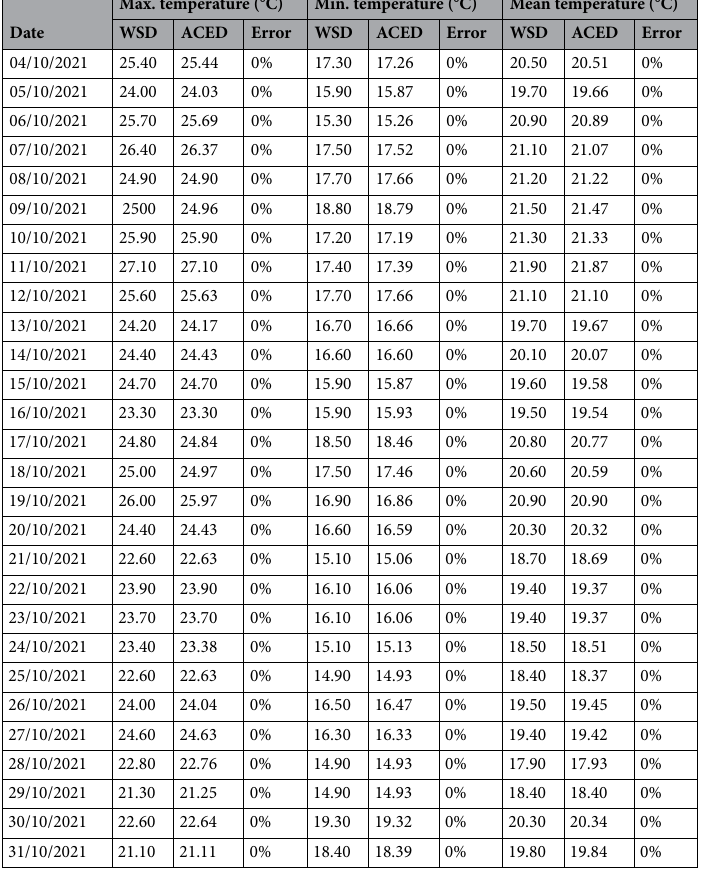
Table 3. Comparison of temperature data obtained by the AgroClimatic web application and by the Meteorological Data Service. WSD: Weather Service Data. ACED: AgroClimatic Evolution